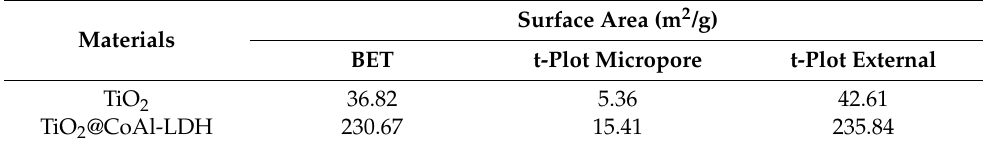
Table 4. Surface areas of TiO 2 and TiO 2 @CoAl-LDH